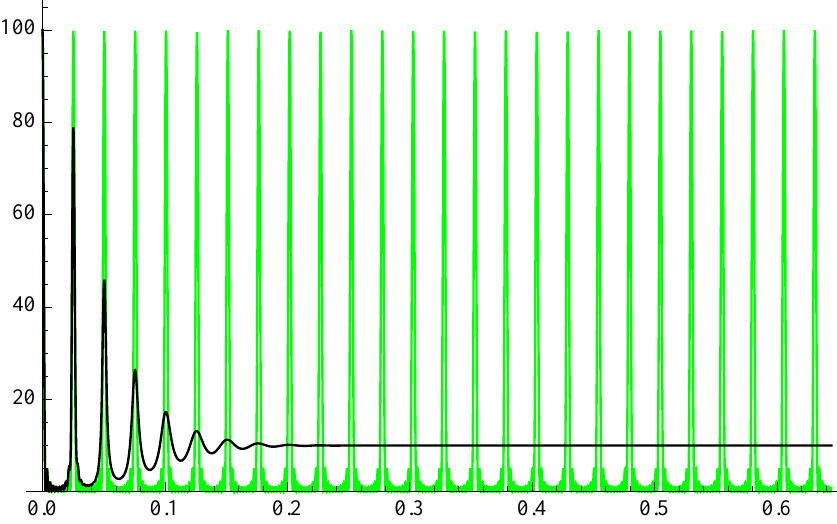
Figure 4. Basic 1D diffraction pattern of the same sequence, just substituting the plane bunches with single plane scatterers—to see the naked decoherence effect of the spacing dispersion. Green—zero dispersion, black—8.5%